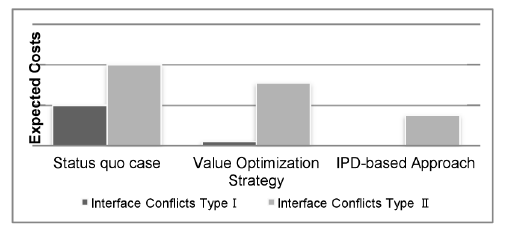
Fig. 5. Comparison of expected cost for interface conflicts in different